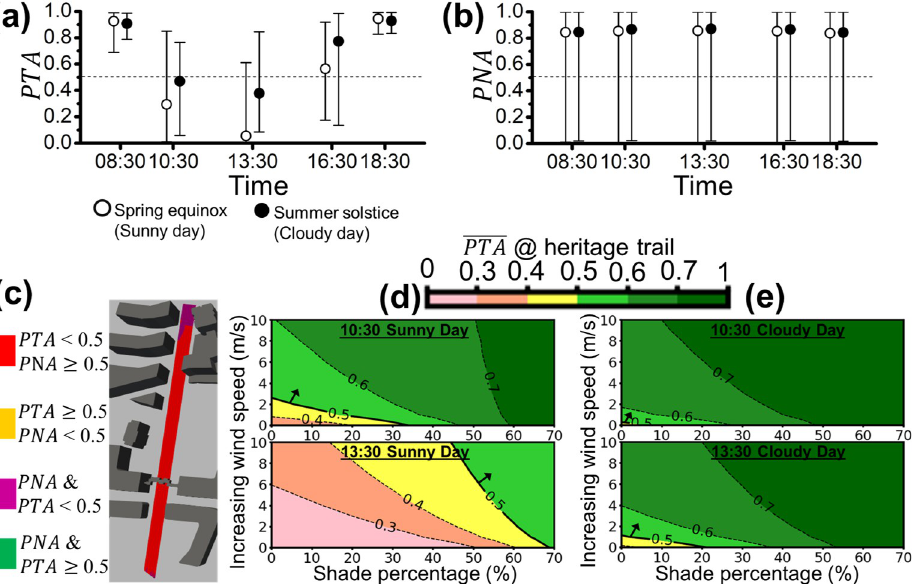
Fig 10. The area-averaged (a) PTA and (b) PNA of the heritage trail (site (ii)) for both sunny (open circles) and cloudy (filled circles) days are represented with open and filled circles (i.e., PTA and PNA ), respectively. The error bars extended from the area-averaged PTA or PNA (circles) represent the local maximum and minimum PTA or PNA on the heritage trail. The environmental acceptability threshold of 0.5 is denoted by the dotted line (i.e., PTA = 0.5 or PNA = 0.5). (c) The spatial plot of PTA and PNA above or below the threshold of 0.5 for heritage trail at 13:30 on the sunny day (worst case) is illustrated. The contour plot shows the potential improvement of PTA with the increase in shade and/or wind speed at 10:30 and 13:30 on (d) the sunny day, and (e) the cloudy day for the heritage